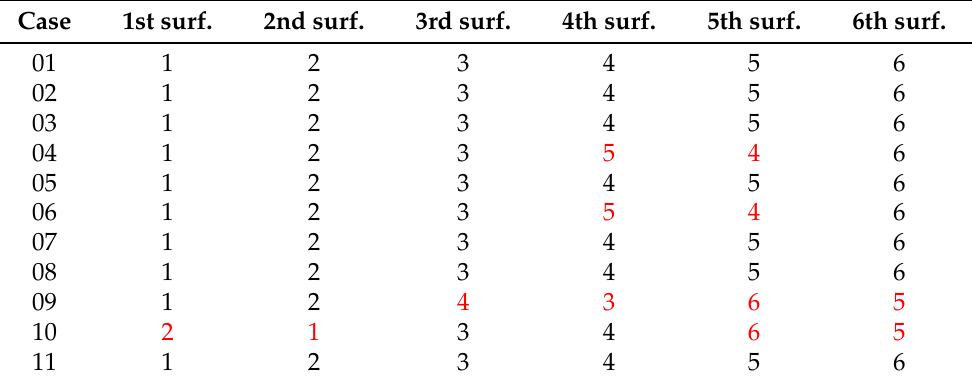
Table 3. Surface ordering. Numbers in red indicate the permutation that must be performed in order to align surfaces with respect to its